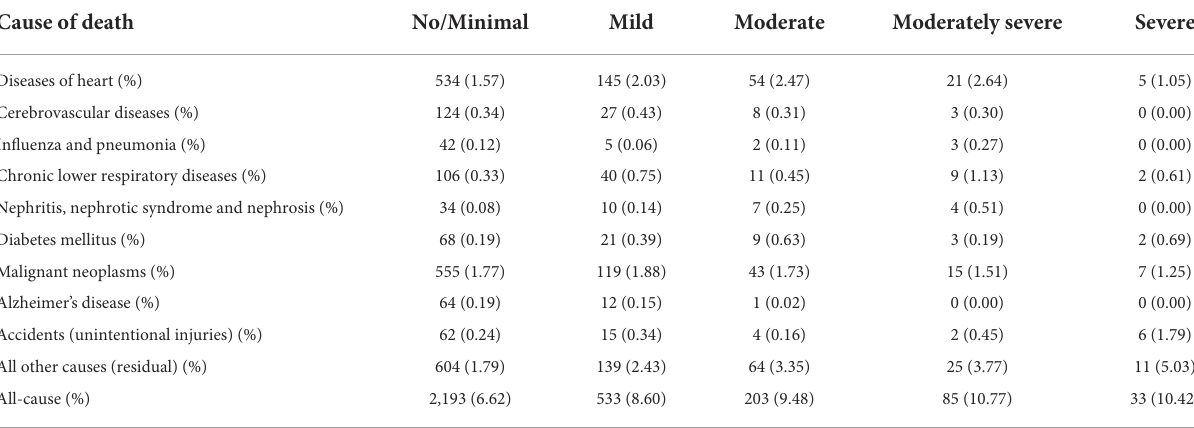
TABLE 3 The weighted percentages of leading causes of death in different depression severity groups.